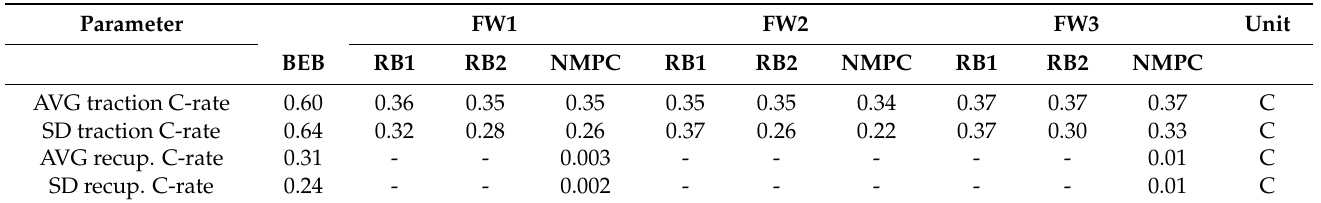
Table A1. Average and standard deviation of the battery C-rate along the E11 driving cycle. Parameter